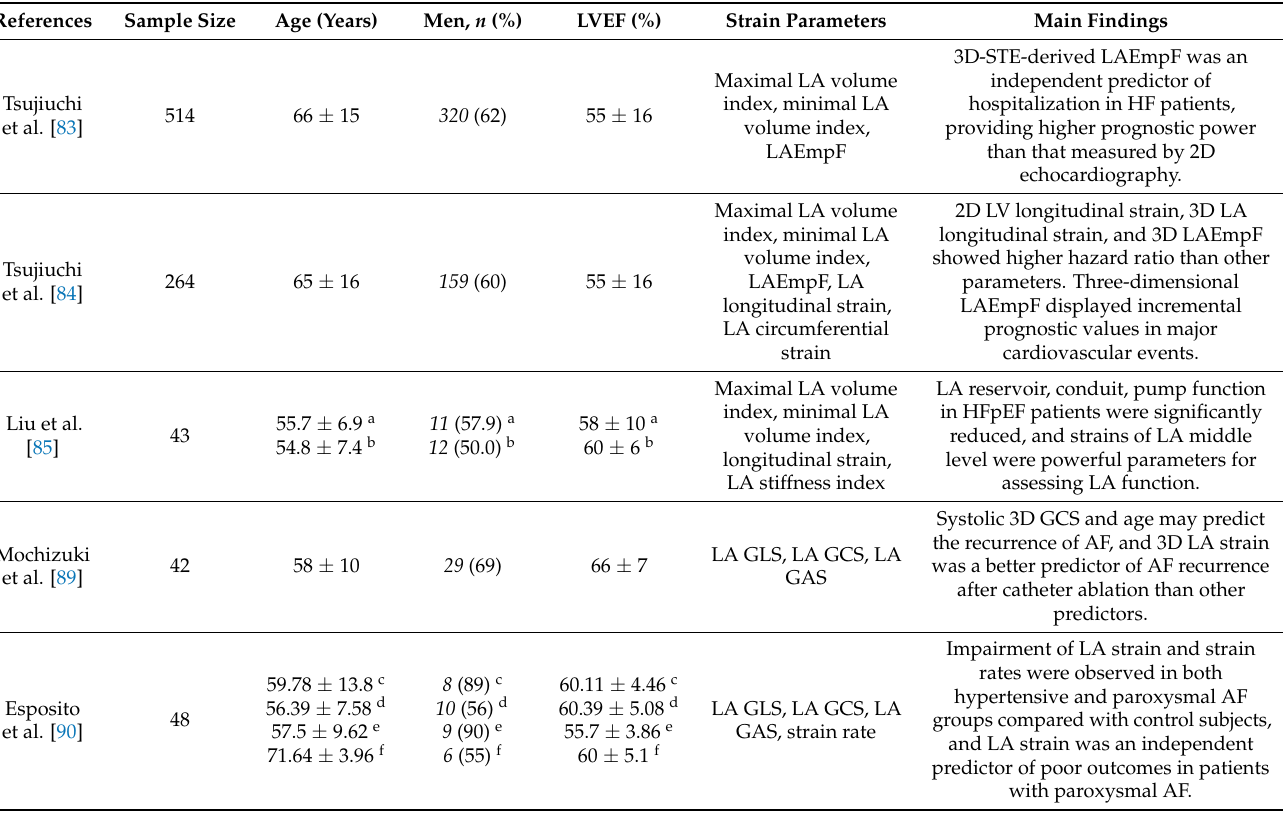
Table 3. Assessment of LA function in HF patients using